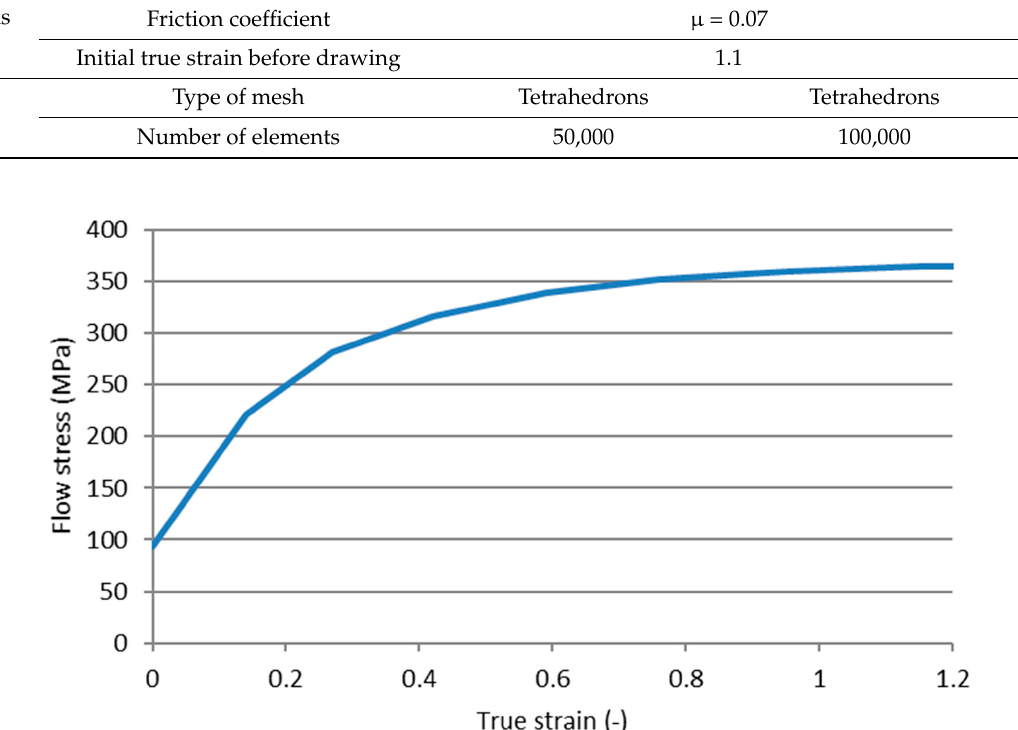
Figure 3. Work hardening curve of Cu-ETP copper in ambient temperature assigned as a model of plastic flow for drawn wire used in FEM (Finite Element Method) simulations .